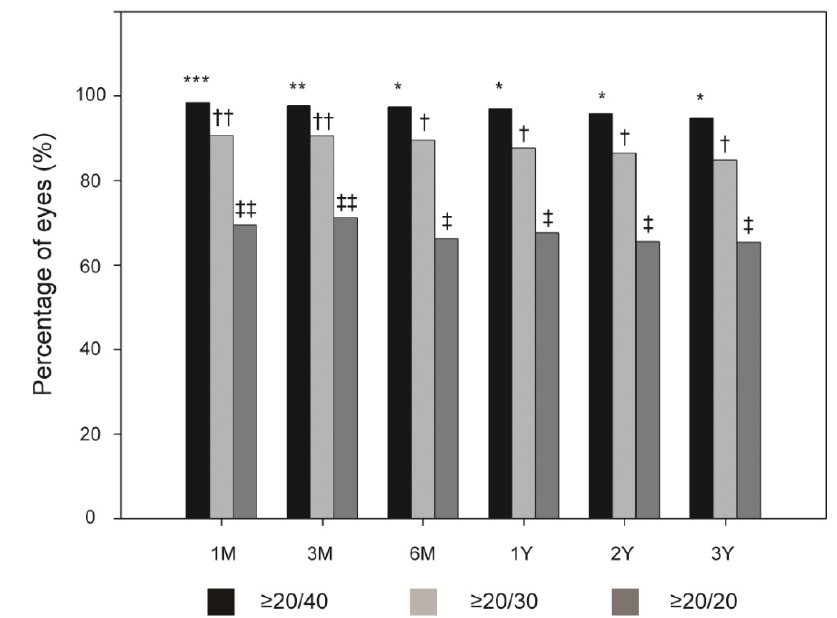
Figure 1. Overall incidence of postoperative uncorrected visual acuity ≥ 20/40, ≥ 20/30, and ≥ 20/20. ***, ** and *; †† and †; ‡‡ and ‡ indicate signi fi cant di ff erences between these time points (all p < 0.005).